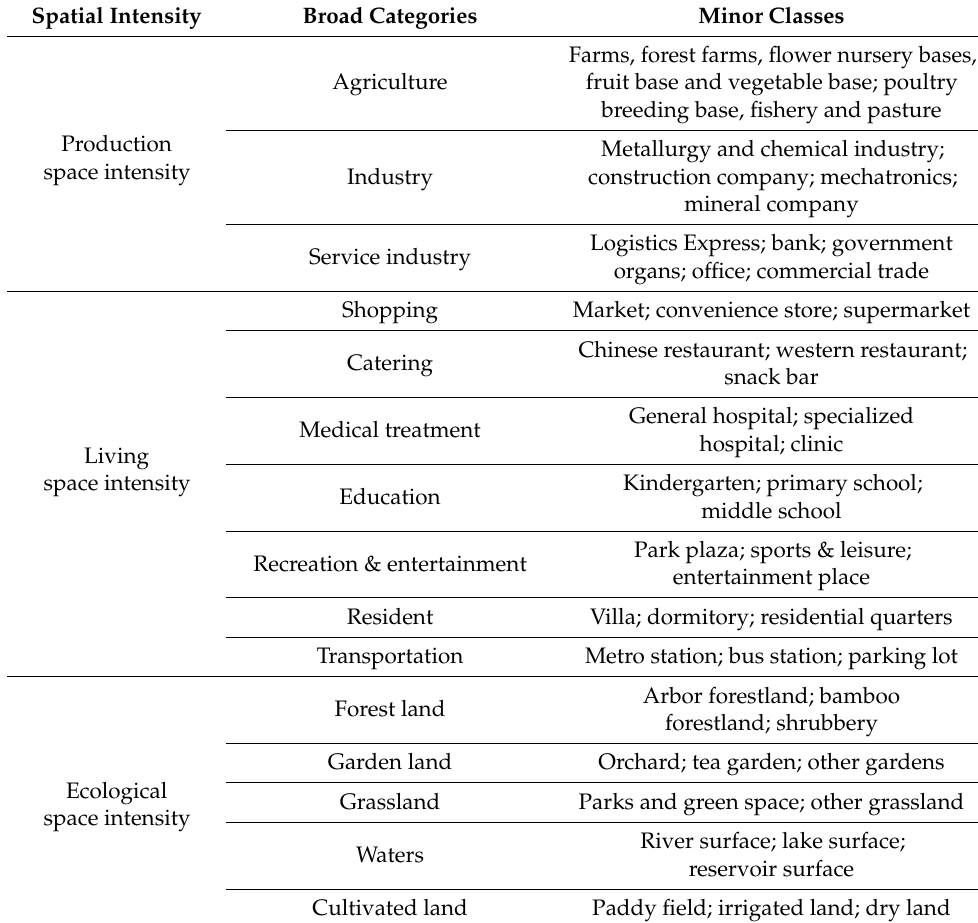
Table 3. Evaluation index of production, living and ecological space intensity based on POI and land use